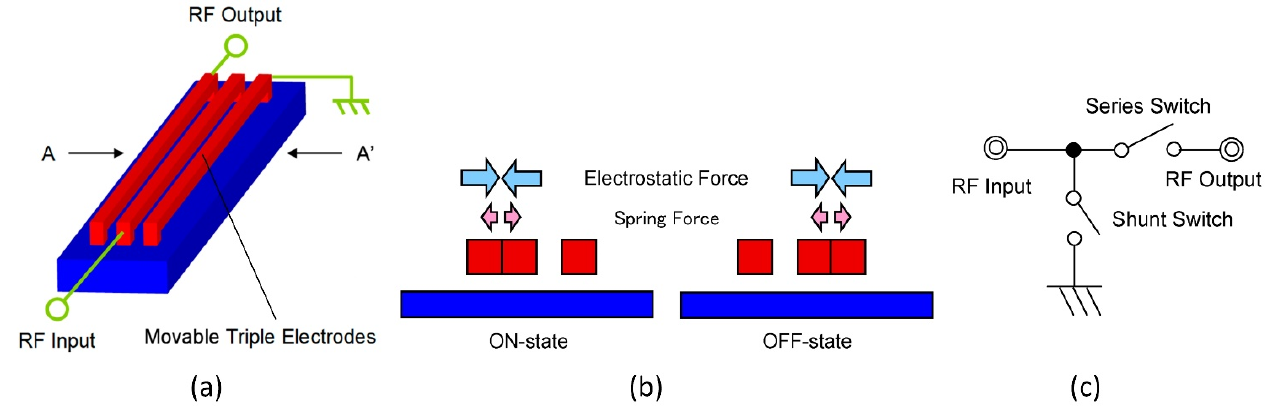
Figure 17. RF-MEMS switch with side movable triple electrodes actuator. ( a ) Overview; ( b ) cross- sectional view between A to A’; ( c ) an equivalent circuit [113].